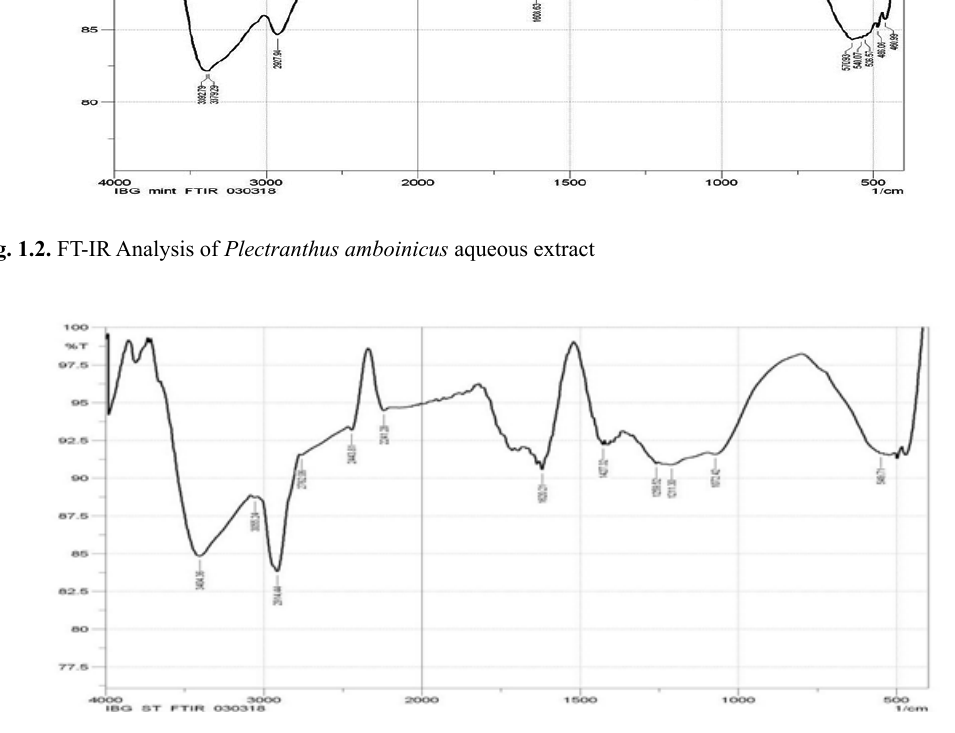
Fig. 1.3. FT-IR Analysis of Ocimum basilicum aqueous